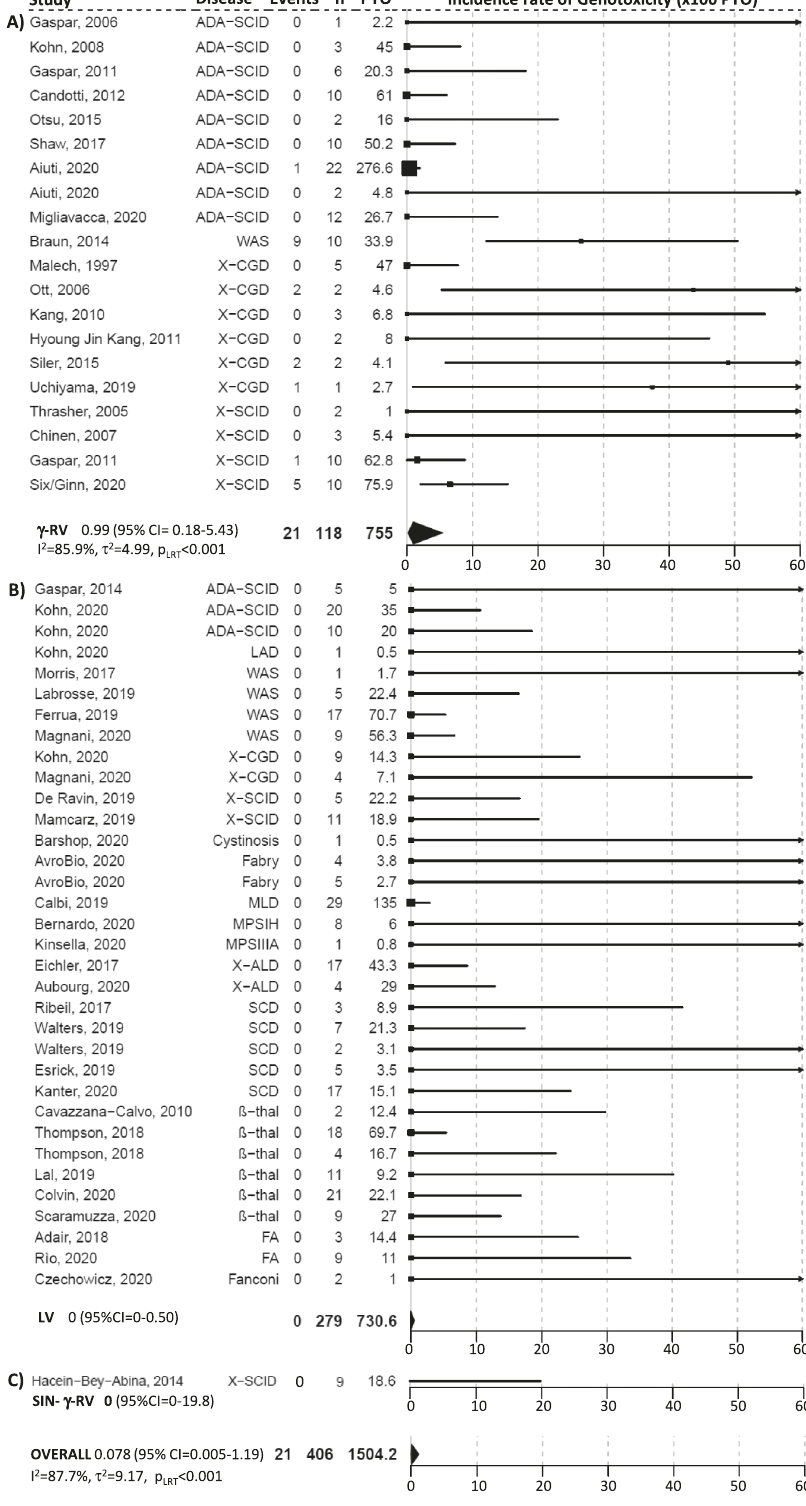
Fig. 3 Forest plot of the incidence rate of genotoxicity by vector type, i.e., (A) γ RV, (B) LV, (C) SIN- γ RV, and overall. The squares indicate the incidence rate of genotoxicity and their size re fl ects the study sample size, while the horizontal lines represent 95% Con fi dence Intervals (CI). The diamond denotes the summary effect size from the random-effects model for all or subgroups of studies (from a meta-regression model), and the width of the diamond depicts the overall 95% CI. The indices of heterogeneity (I 2 and τ 2 ) refer to the overall analysis or to the single subgroups, and p LRT is the p-value for the test of residual heterogeneity, while p QM refers to the test on vector type as moderator. All tests were two-tailed. Source data are provided as a Source Data fi